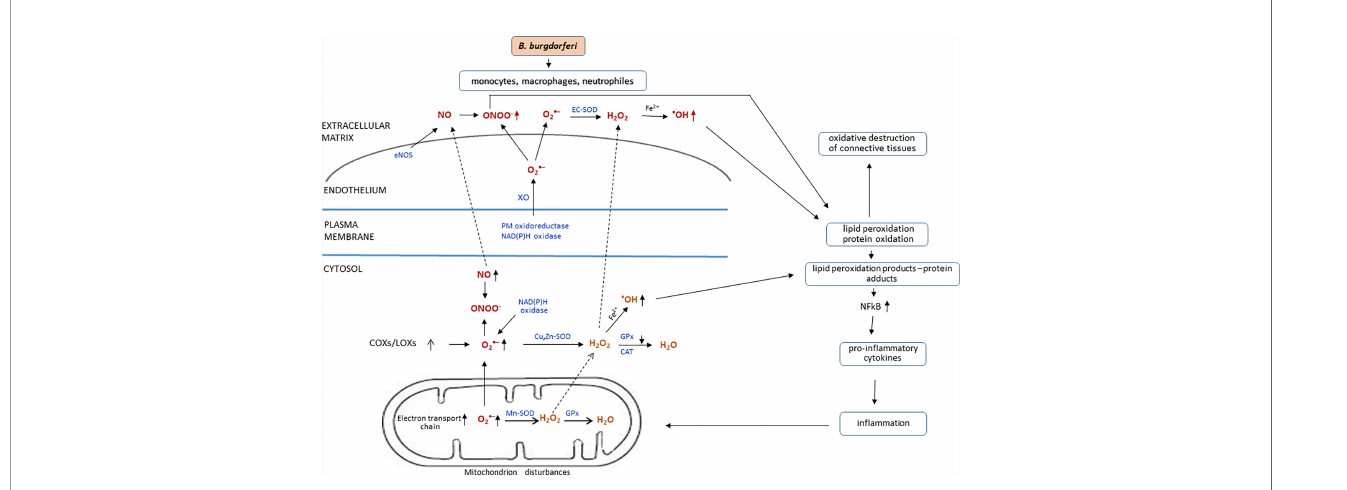
FIGURE 3 | Redox imbalance and metabolic effects of B . burgdorferi